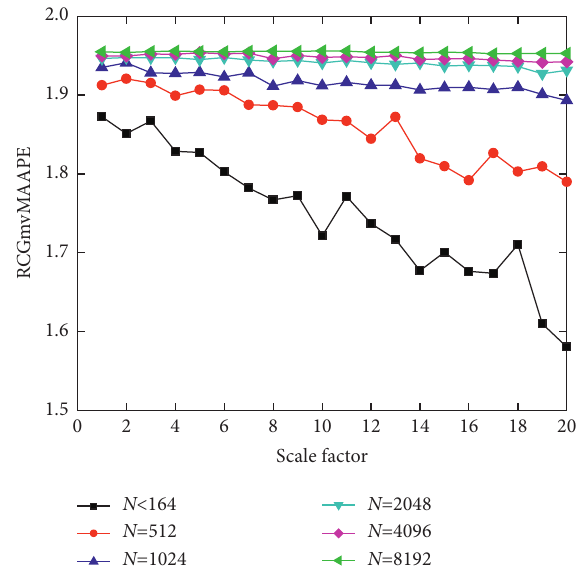
Figure 4: RCGmvMAAPE of three channel white noises under diverse